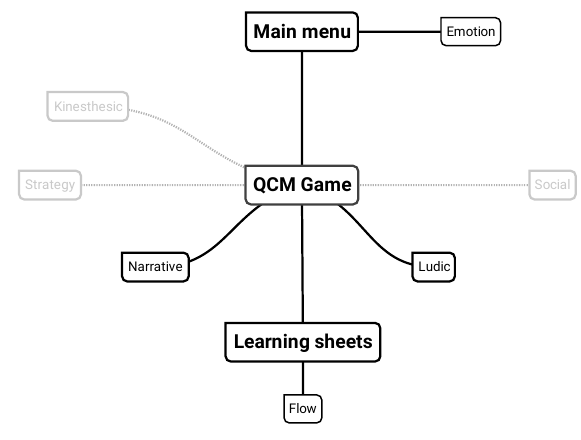
Figure 2. Illustration showing the general architecture of QCM, with the associated involvement